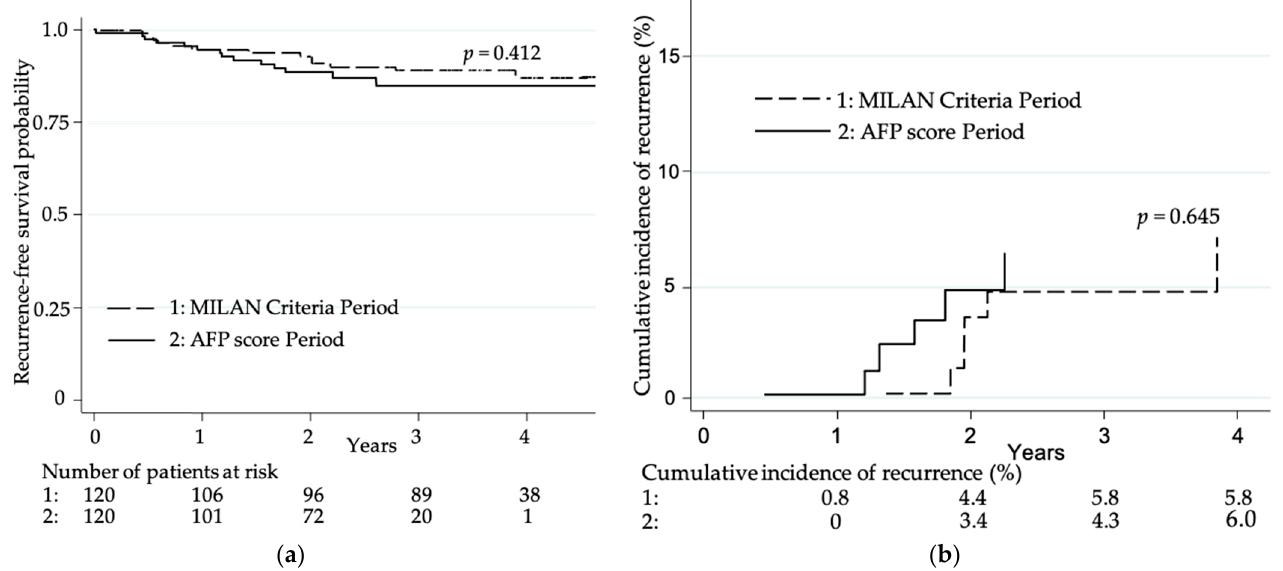
Figure 2. Risk of recurrence: ( a ) probabilities of recurrence-free survival according to Kaplan–Meyer estimates; ( b ) cumulative incidence of recurrence on competing analysis (Fine and Gray model).